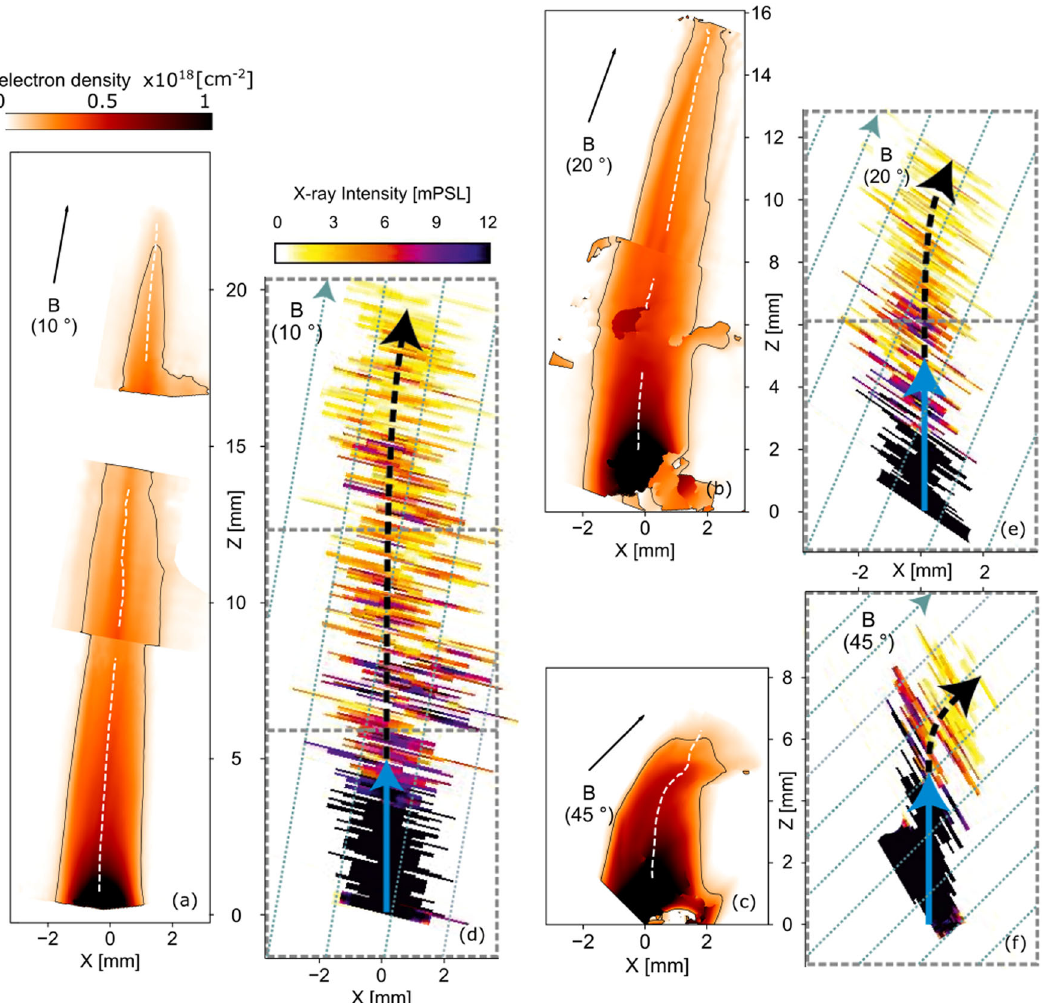
Fig. 2 Laboratory plasma expansion observed in misaligned con fi gurations. a Laboratory electron density integrated along the probe line of sight, in a 20 T case at 36 ns, retrieved via interferometric measurement (see ” Methods ” section), with a misalignment of α = 10 degrees between the target and the magnetic fi eld. The target normal is along z (as illustrated by the dashed gray arrows in Fig. 1A). b Same as a , with α = 20 degrees. c Same as a and b with α = 45 degrees, and at 16 ns after the laser interaction. d , e , f Same as a , b , c regarding the magnetic fi eld angles, but as measured by X-ray spectroscopy inferred from He line emission (transition He 4p – 1s on the Fluorine ion); the X-ray measurements are integrated in time (see “ Methods ” section and Supplementary Note 2). In a , b , c , the white dashed line follows the center of mass, measured from these electron density maps, assuming a constant ionization state at a given distance from the target (the lines are interrupted when the density map is noisy or when transiting from a frame to another, in order to reconstruct the full jets — see “ Methods ” section); the contour follows the 1 × 10 17 cm − 2 integrated density value; the black arrows indicate the initial magnetic fi eld direction. In d , e , f , the images are the result of a combination of different frames (shown by the dotted rectangles), in order to reconstruct the full jets (see “ Methods ” section); the dashed blue lines indicate the magnetic fi eld direction; the solid blue and dashed black arrows are here to guide the eyes on the bending of the 2D X-rays pattern. In all cases, z = 0 represents the target